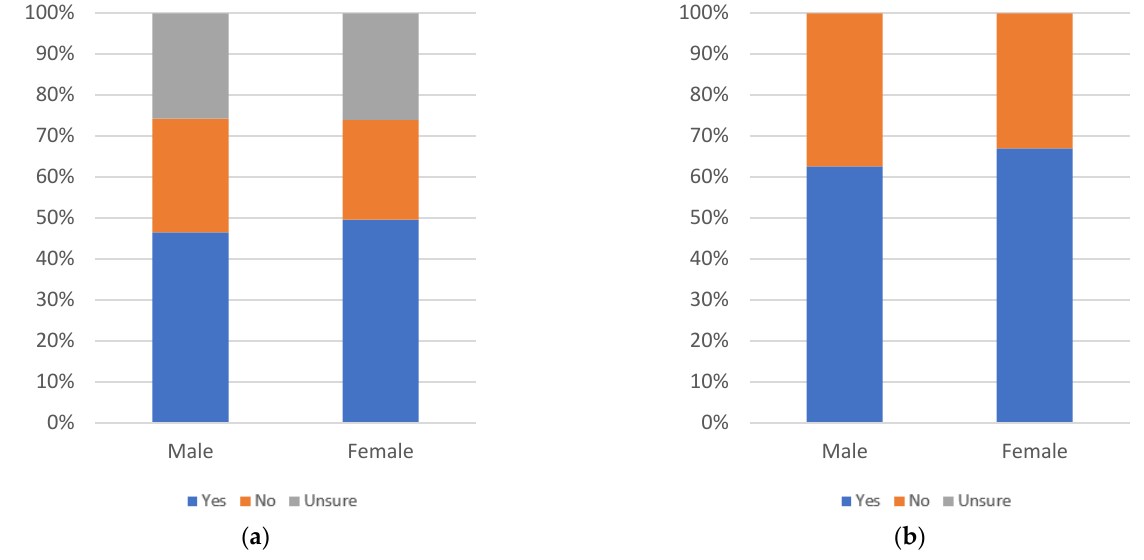
Figure 48. Label others’ use, by gender: ( a ) with uncertain respondents (left) and ( b ) without uncertain respondents (right).